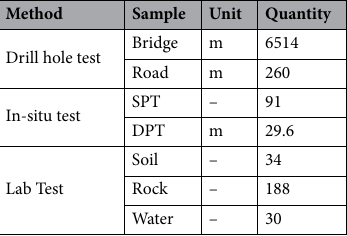
Table 2. Sample quantities of the